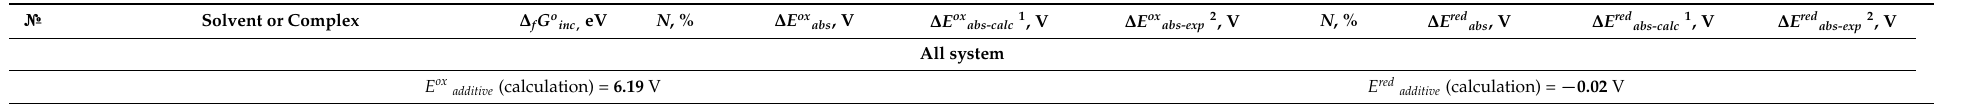
∆ E ox abs-exp —experimentally measured value of